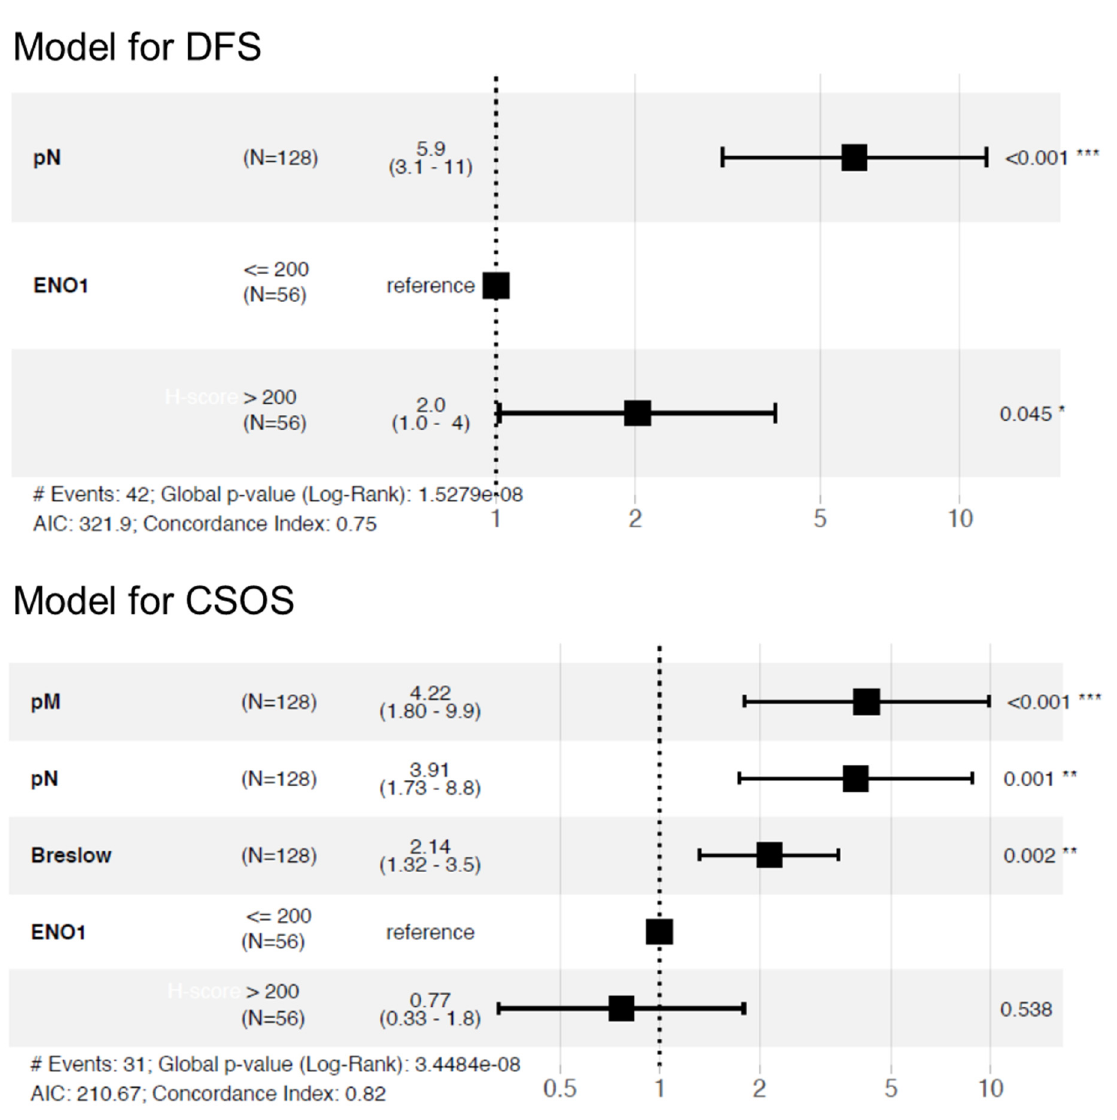
Figure 7. Multivariable regression model for disease-free survival and cancer-specific overall survival in cutaneous melanoma patients (DFS (disease-free survival), CSOS (cancer-specific overall survival).